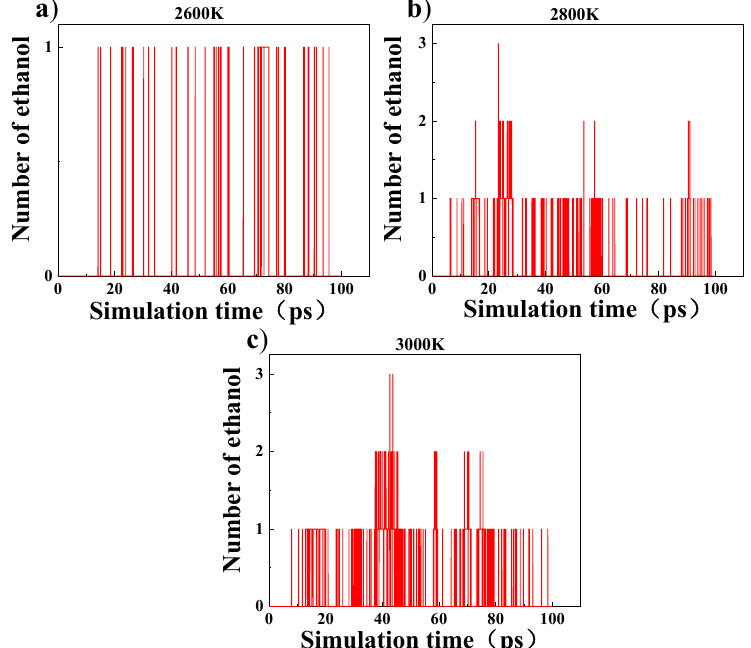
Figure 7. The curve of 40 cellobioses to produce ethanol